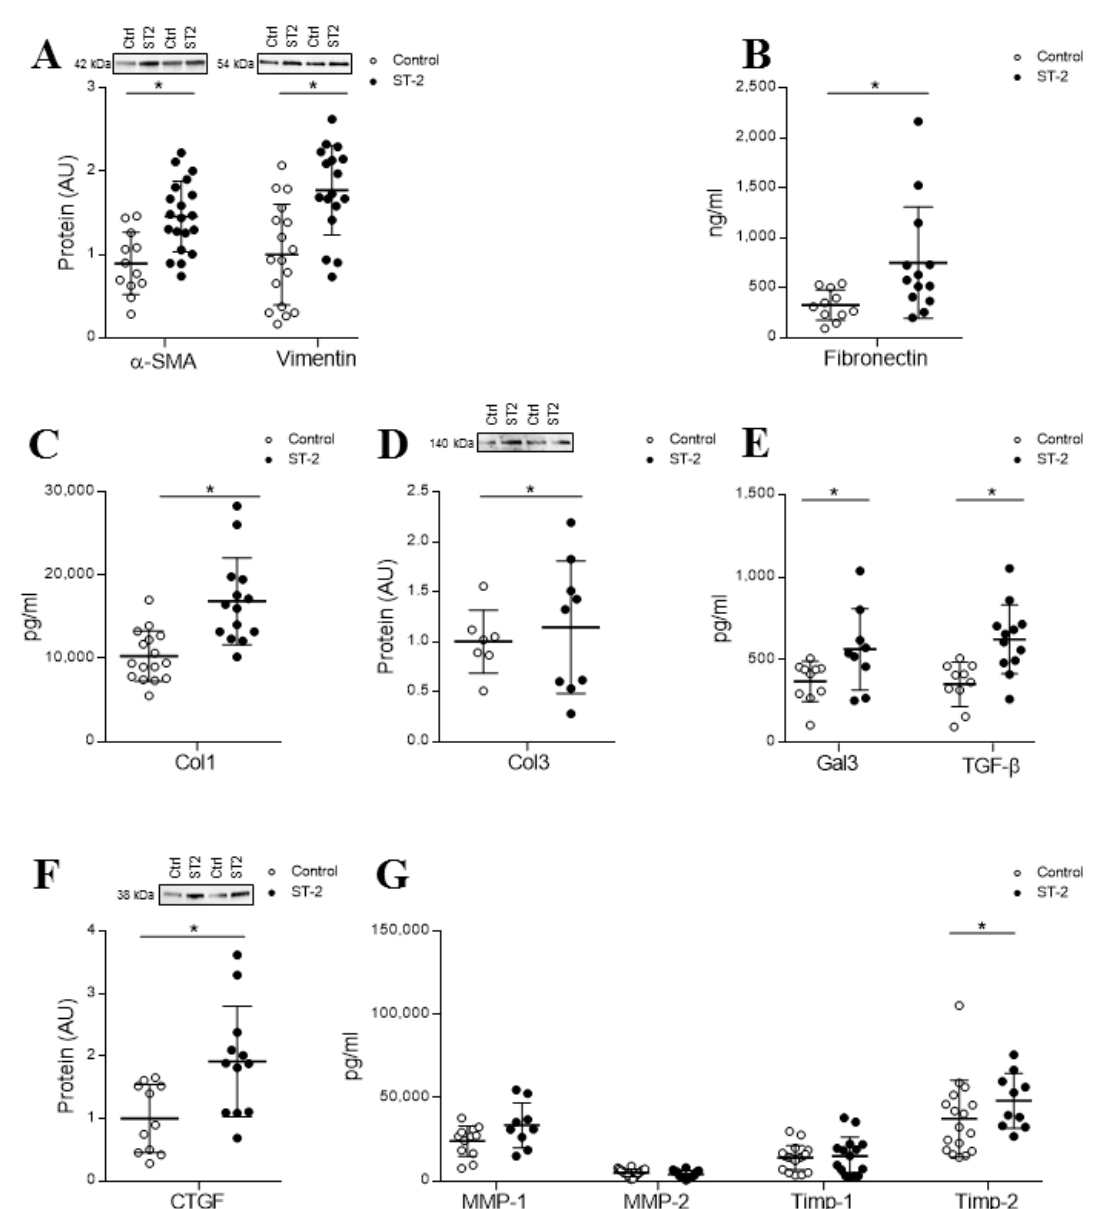
Figure 1. Soluble interleukin 1 receptor-like 1 (sST2) effects on fibroblast activation markers, collagens and profibrotic molecules in adult human cardiac fibroblasts (HCFs). The 24-h sST2 treatment (2 μ g/mL) effect on α -SMA, vimentin ( A ), fibronectin levels ( B ), Col-1 ( C ) and Col-3 expression ( D ) in HCF. Effects of sST2 on the profibrotic markers Gal-3 and TGF- β 1 ( E ) and CTGF ( F ). Effects of sST2 on MMP-1, MMP-2, TIMP-1 and TIMP-2 release ( G ). All conditions were performed at least in triplicate. Scatter dot plots represent the median and minimum to a maximum range of N = 7-20 replicates per condition. For Western blot experiments, protein densitometry was expressed in arbitrary units (AU) once normalized to stain-free for proteins. Representative blots have been displayed when appropriate. * p < 0.05 vs. control. α -SMA, smooth muscle actin; Col-1, collagen type I; Col-3, collagen type III; CTGF, connective tissue growth factor; TGF- β 1, transforming growth factor beta; Gal-3, galectin-3; MMP, metalloproteinase and TIMP, tissue inhibitor of metalloproteinase. 4.2. sST2 Upregulates NRP-1 in Adult Human Cardiac Fibroblasts A proteome-wide analysis of total cell extracts using isobaric tags (iTRAQ) coupled to 2D nano- liquid chromatography tandem mass spectrometry was performed in HCF treated with sST2 as